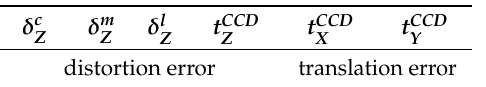
Table 2. Image error types caused by di ff erent thermal behaviours.